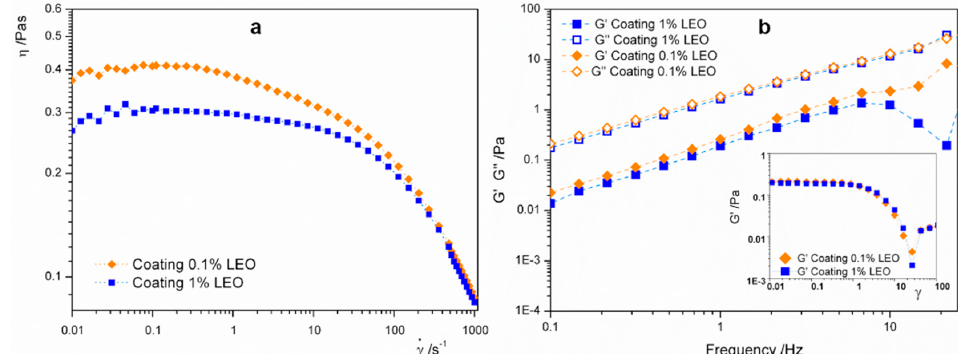
Figure 2. ( a ) Apparent viscosity curves as function of the shear rate for alginate based nanoformulations containing 0.1% LEO or 1% LEO; ( b ) frequency sweep spectra of nanodispersions; storage moduli G’ represented with full symbols and loss moduli, G” , represented with empty symbols. Inset shows strain sweep of nanoformulations highlighting the linear viscoelasticity region. Nanoformulation containing 0.1% LEO is represented with orange diamonds, nanoformulation with 1% LEO is represented with blue squares.